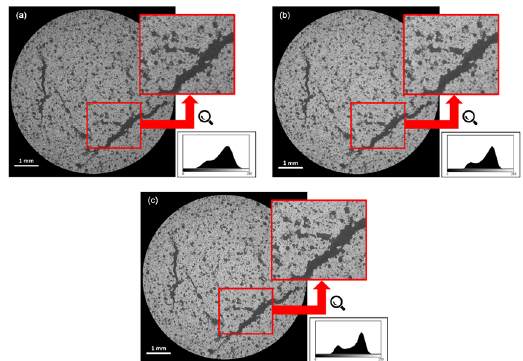
Figure 7. Image processing steps and respective histograms. (a) Original image; (b) After the Non-Local Means filter; (c) After edge enhancement.